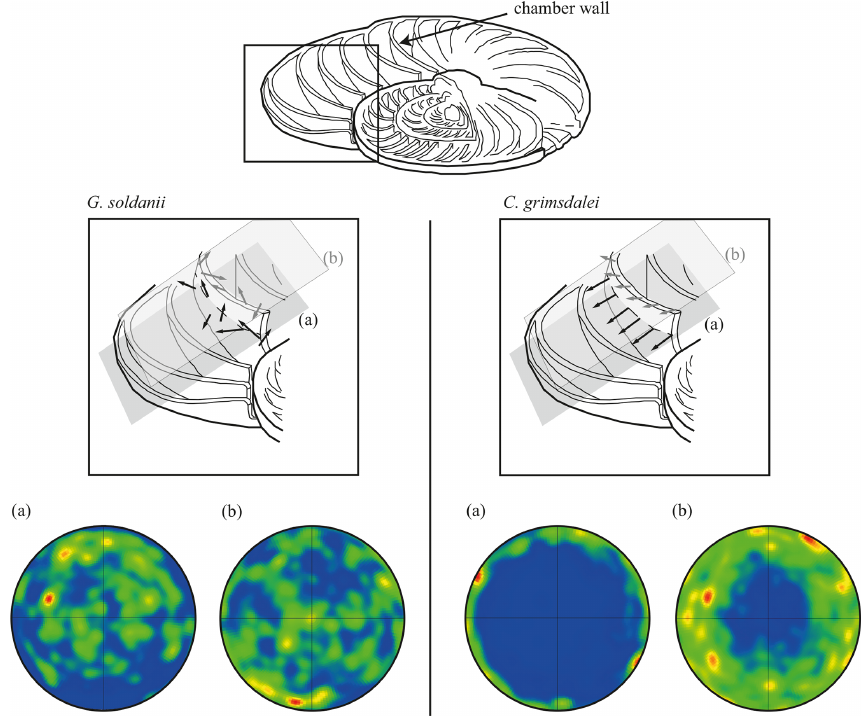
Figure 7. Effect of cutting position on the distribution of c axes. (a) Cutting in plane of largest diameter (equatorial plane, dashed line). (b) Off-equator cutting position. Cutaway image of foraminifer test modified after Evans et al. (2013). Black arrows visualize direction of c axes in the equatorial plane (a) , while grey arrows indicate c axes in the off-equatorial surface (b)